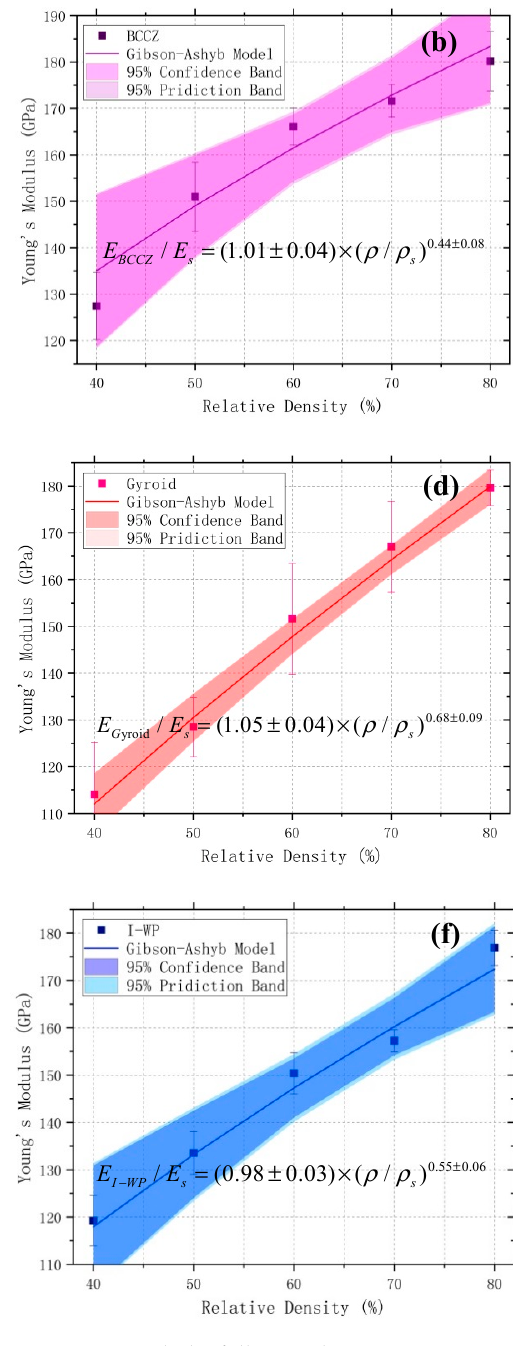
Figure 7. Gibson-Ashby model fitting curves for test specimens with the following lattice structures: ( a ) BCC; ( b ) BCCZ; ( c ) honeycomb; ( d ) gyroid; ( e ) primitive; and ( f ) I-WP. The darker and lighter colored bands in each figure represent the 95% confidence band and 95% prediction band, respectively.